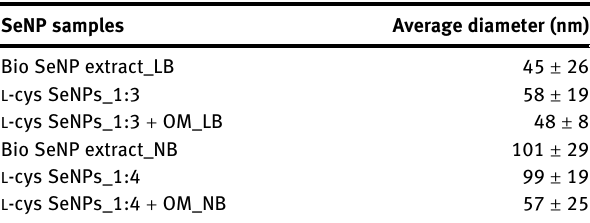
Table  : Average diameter of chemogenic and biogenic SeNPs. SeNP